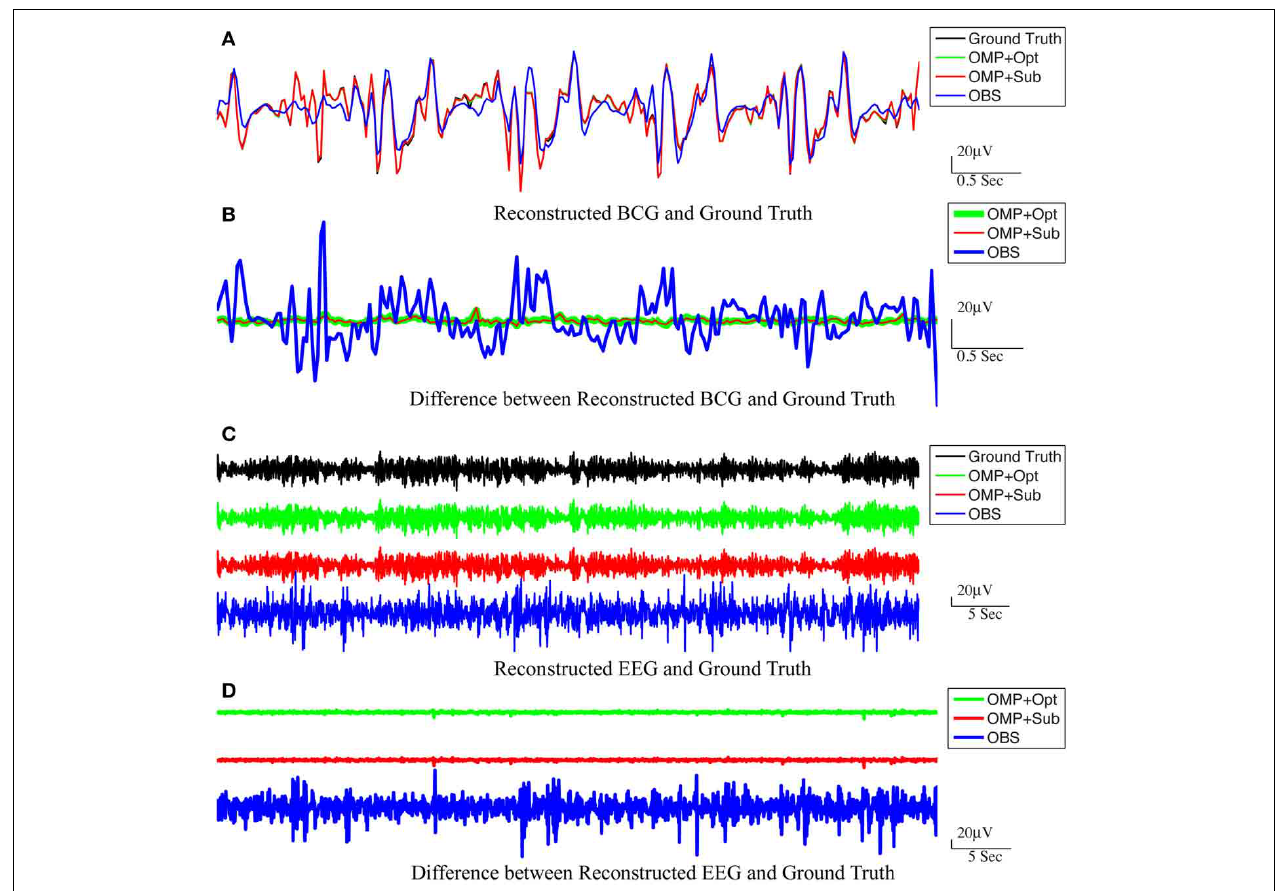
FIGURE 5 | Reconstructed BCG (A) and EEG (C) from channel 118. In (A,C) , the top panel: ground-truth used in simulation. From second to bottom panels, the methods used to reconstruct the signals are OMP with direct